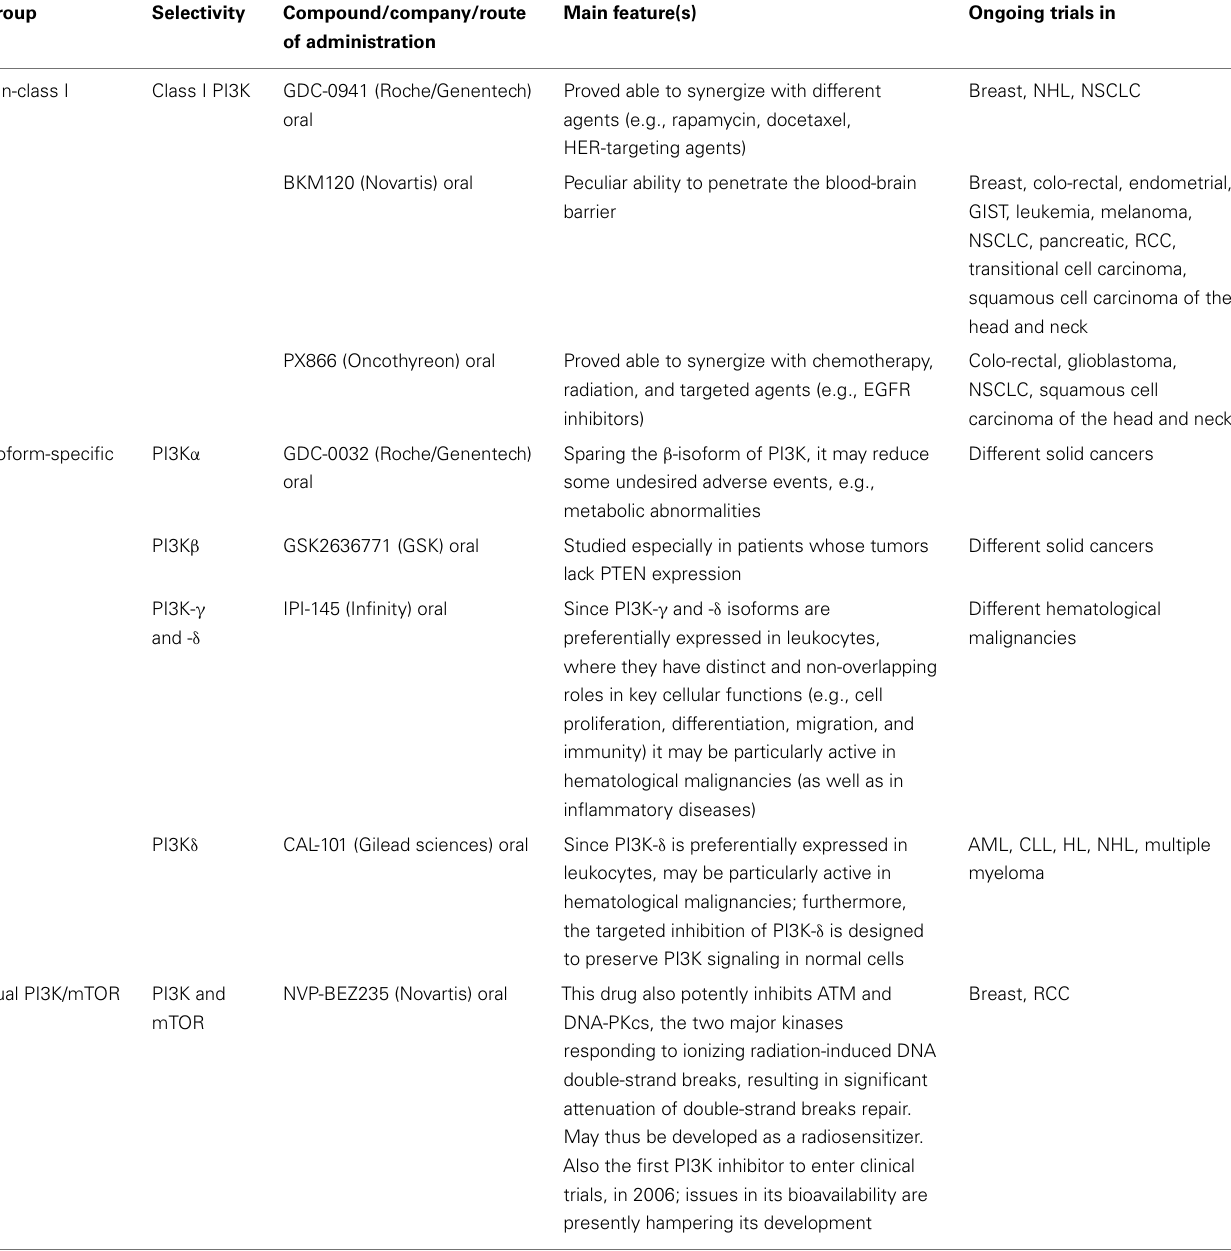
Table 2 | Phosphatidylinositol-3-kinase and “dual PI3K and mTOR” inhibitors in development [modified from ref. (53)] .